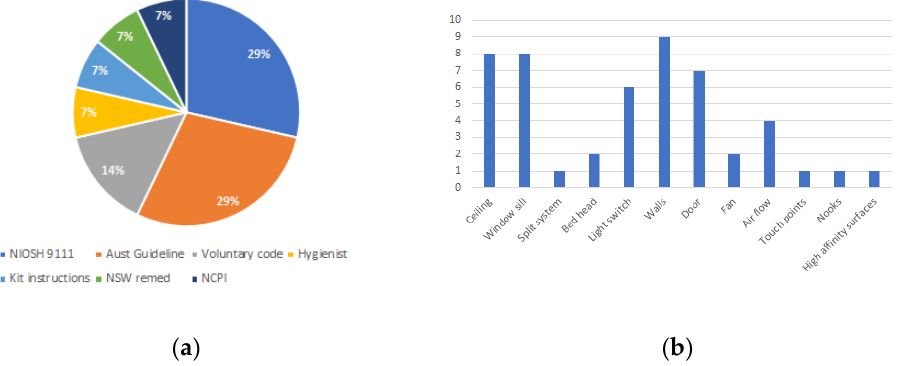
Figure 2. ( a ) Guidelines followed for sampling; ( b ) sampling locations in a contaminated bedroom.